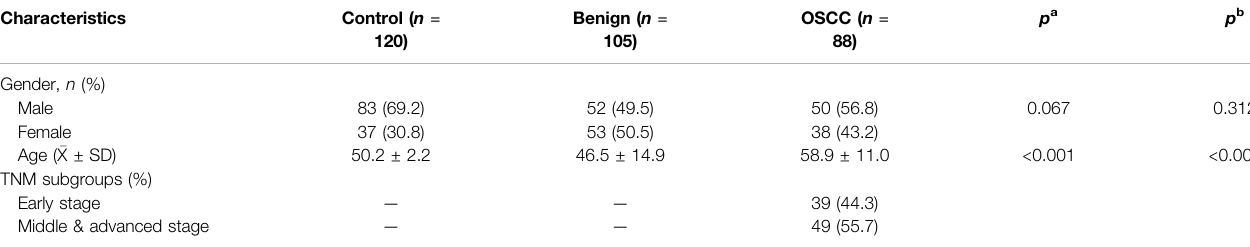
TABLE 1 | Demographic and clinical characteristics of control, benign-tumor and OSCC subjects.